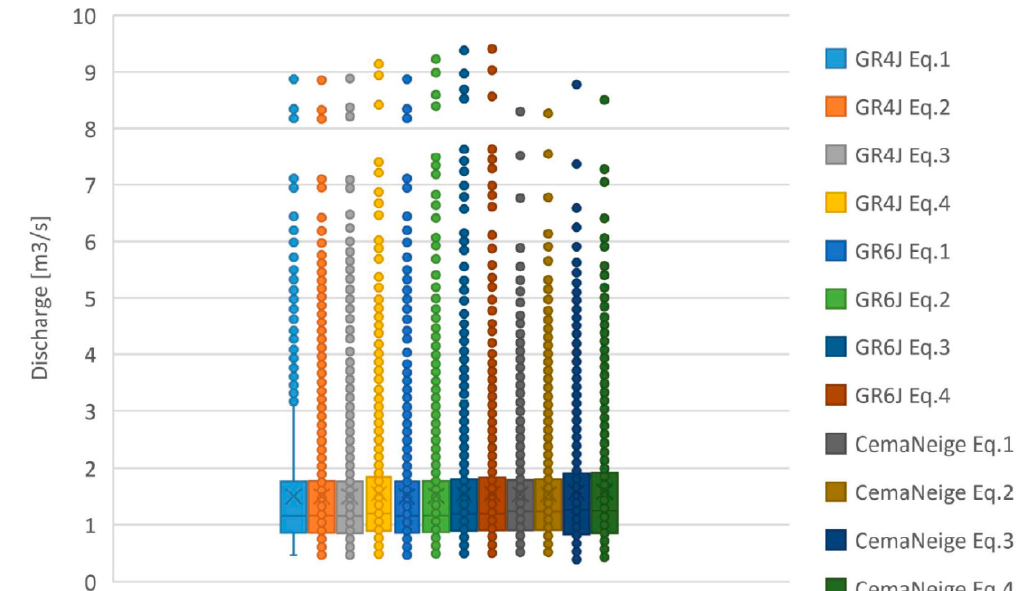
Figure 4. Comparison of di ff erent model results using di ff erent estimates of mean daily air temperature Figure 4. Comparison of different model results using different estimates of mean daily air Figure 4. Comparison of different model results using different estimates of mean daily air Figure 4. Comparison of different model results using different estimates of mean daily air values for the Kranjska Gora station on the Sava Dolinka river. temperature values for the Kranjska Gora station on the Sava Dolinka river. temperature values for the Kranjska Gora station on the Sava Dolinka river. temperature values for the Kranjska Gora station on the Sava Dolinka river.